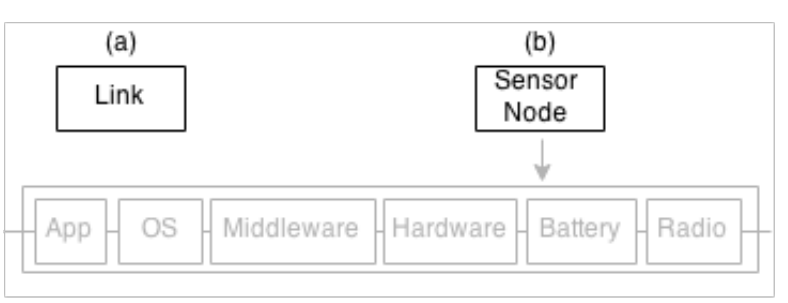
Figure 10. Basic blocks of the reliability model.